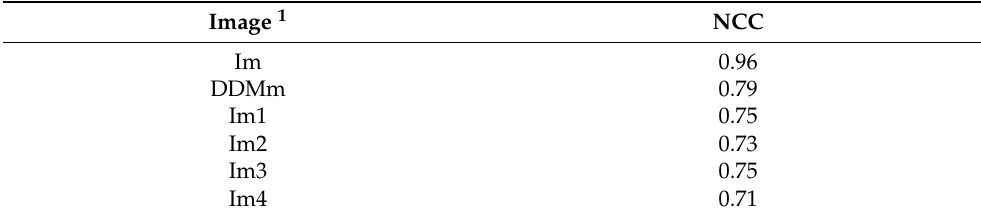
Table 2. Comparison between COL7 and COL7-h.